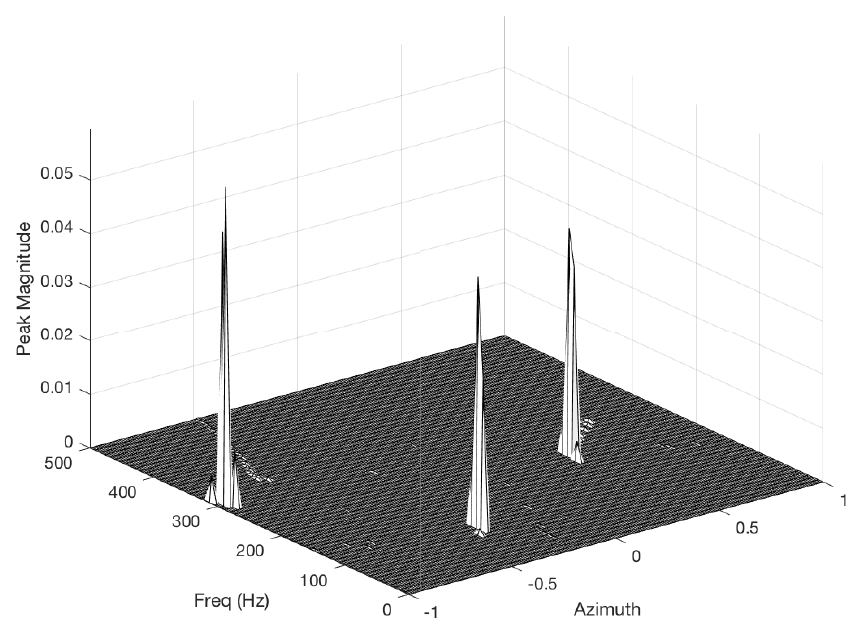
Figure 3. The frequency-azimuth plane constructed for the mixtures x 1 and x 2 are illustrated for the frequency range 0 500 Hz and for gains (or azimuths) f ≤ ≤ the gains 0.35 and 0.4 for the s 1 and s 2 at frequencies 100 Hz and 200 Hz, respectively. The 300 Hz − component of s 1 and s 2 does not appear as two separate peaks, but as one peak with a gain that is inconsistent with s 1 and s 2 ’s azimuth.